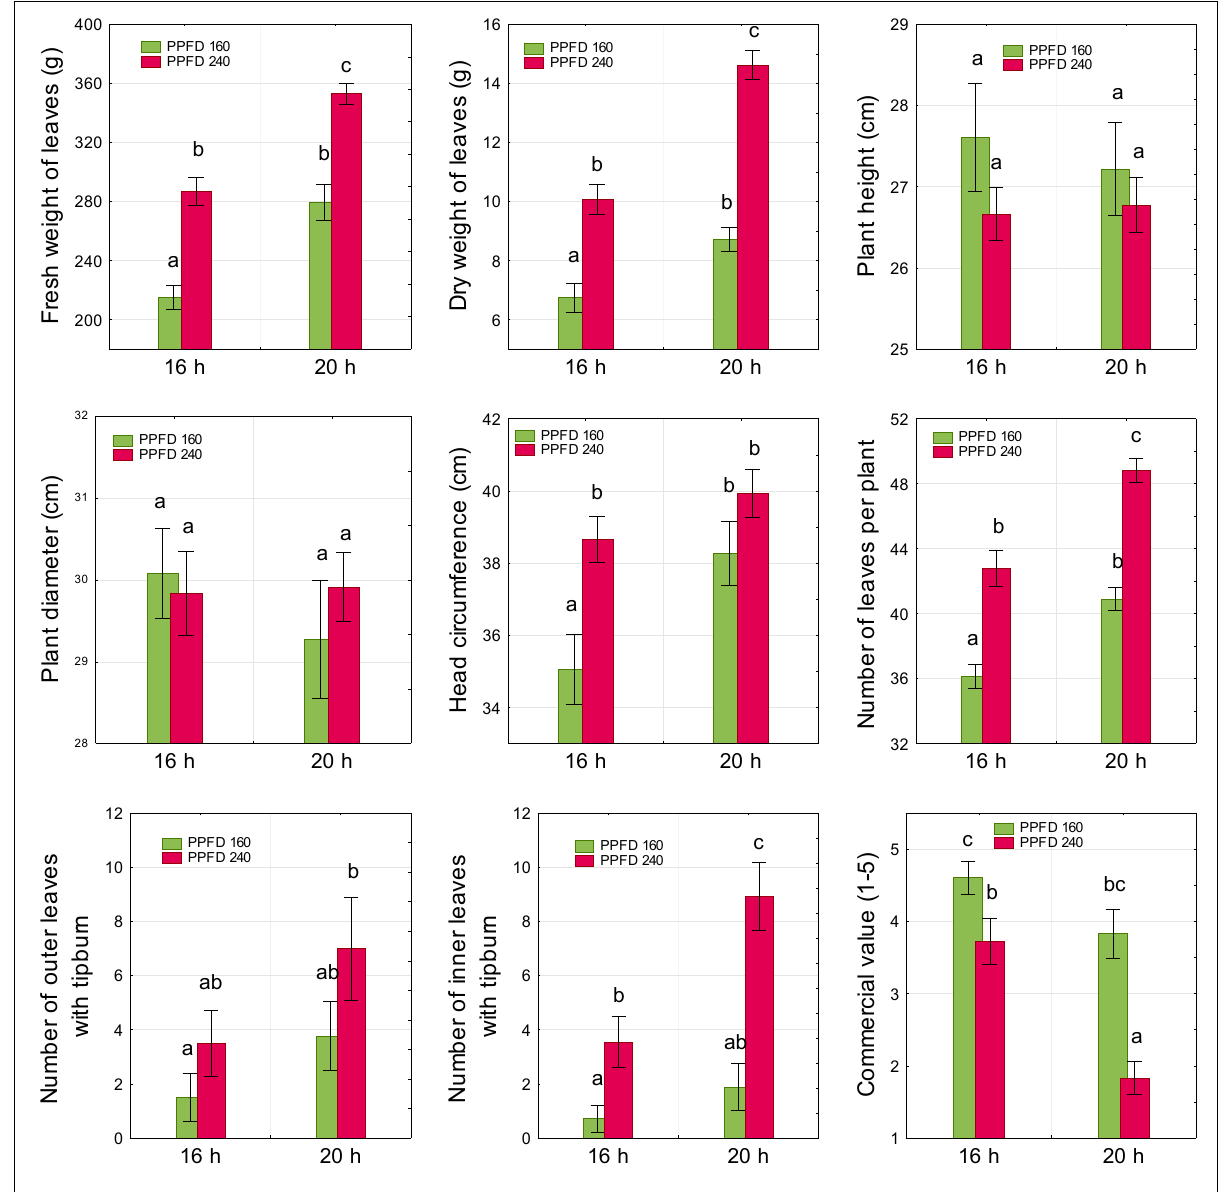
Figure 1. Fresh and dry weight of leaves, plant height, plant diameter, head circumference, number of leaves per plant, number of outer and inner leaves with tipburn, and commercial value of cv. ‘Casual’ romaine lettuce grown under different light environments (photoperiod 16 and 20 h and PPFD 160 and 240 µ mol m − 2 s − 1 ). Bars represent means ± SE. Means followed by the same letter are not significantly different ( p < 0.05) according to Tukey’s HSD test.